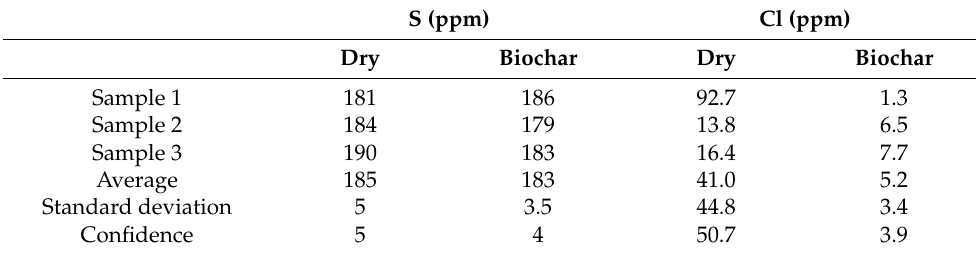
Table 4. S and Cl